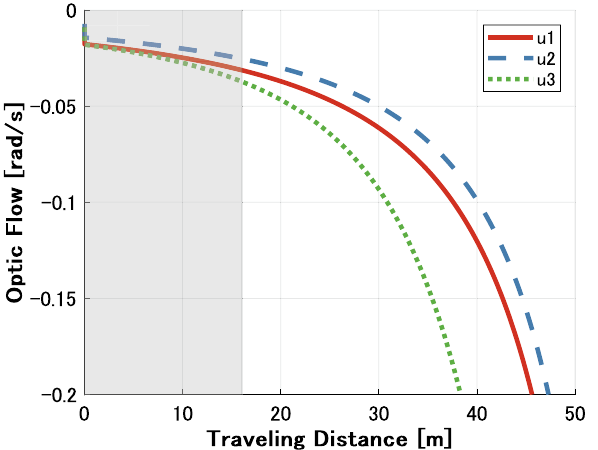
Figure 9. Simulation results of ordinary drivers while driving along a straight path approaching a circular path. The optical flows according to each situation in Fig. 5 represent u 1 , u 2 , and u 3 calculated by (6), (8), and (10). The gray zone denotes that the TP is recommended because the values of u 1 and u 3 are closer than the values of u 1 and u 2